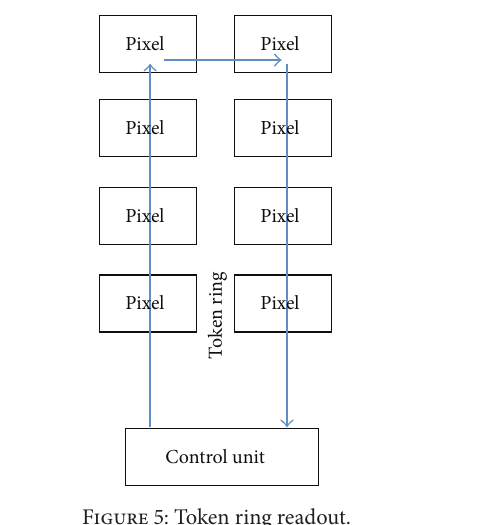
Figure 5: Token ring readout.